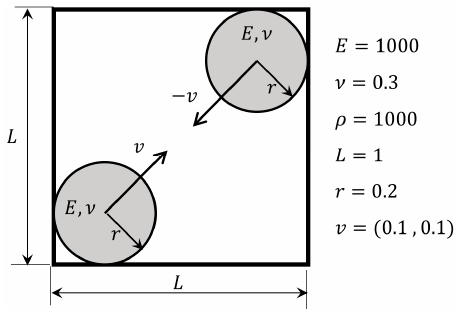
Figure 11. Problem statement of two 2D elastic disks’ impact.